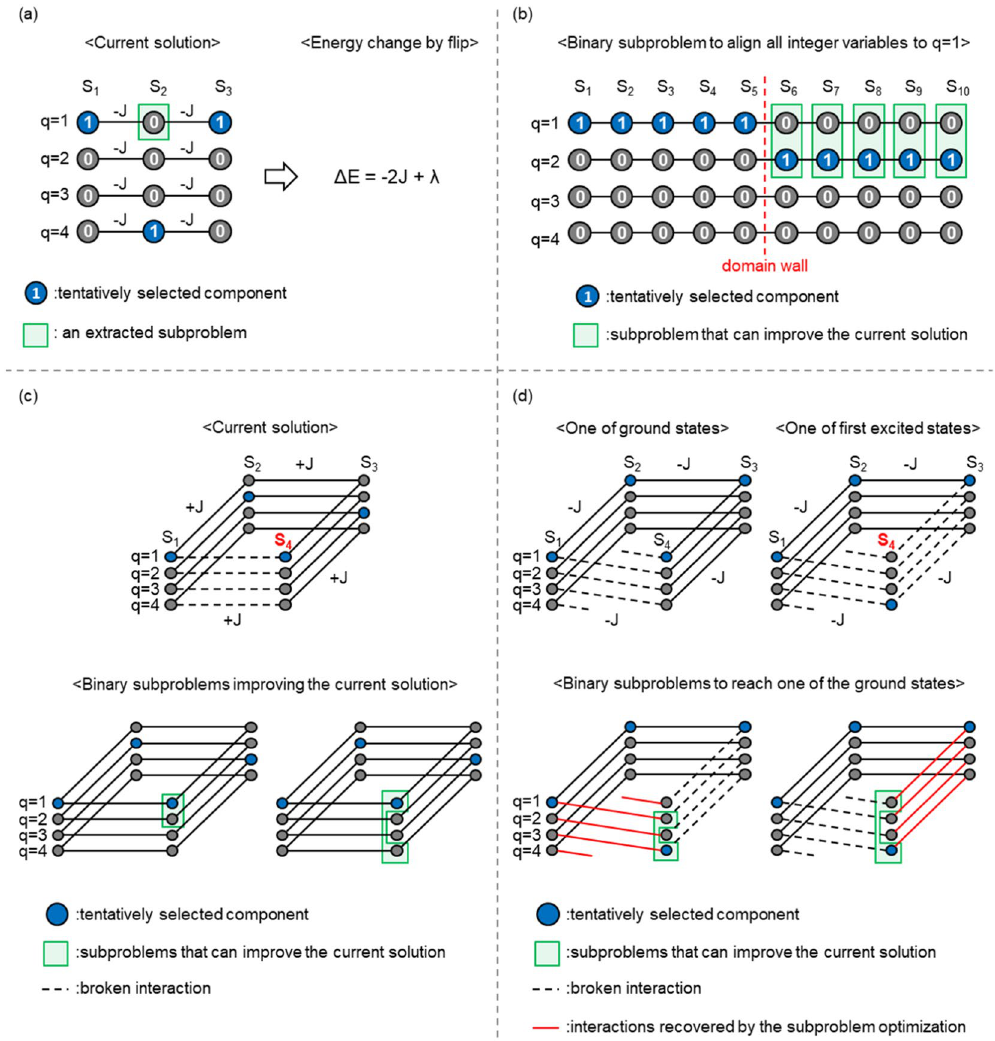
q ( ) and the interactions Figure 6. Discussion on results. Vertices and edges represent binary variables x { } i between them, respectively. Binary variables colored blue are tentatively selected components, and binary variables enclosed by green rectangles are the extracted subproblem. ( a ) Simple example of the random partition that can reduce the energy despite violating the one-hot constraint. ( b ) One of the first excited states commonly observed in the optimization of the ferromagnetic Potts model. To align all integer variables { S i } i = 1,2,...,10 to q = 1, component q = 1 must be selected for variables S 6 , ..., S 10 . ( c ) Local interactions in the anti- ferromagnetic Potts model. The two binary subproblems can improve the current solution. ( d ) Simple example of the Potts gauge glass model. One interaction is broken in the ground state due to competing interactions between different components. Two binary subproblems can improve the first excited state. Broken interactions are represented by dashed lines, while interactions recovered by optimizing the binary subproblem are represented by red Potts glass and Potts gauge glass models, we did not identify problems for which the multivalued partition is most suitable. Future studies should focus on constructing algorithms that can efficiently solve the ferromagnetic Potts model using the binary partition. In addition, the performance of the proposed methods should be assessed for various optimization problems, such as the graph coloring problem whose cost function is represented as the Hamiltonian of the anti-ferromagnetic Potts model.